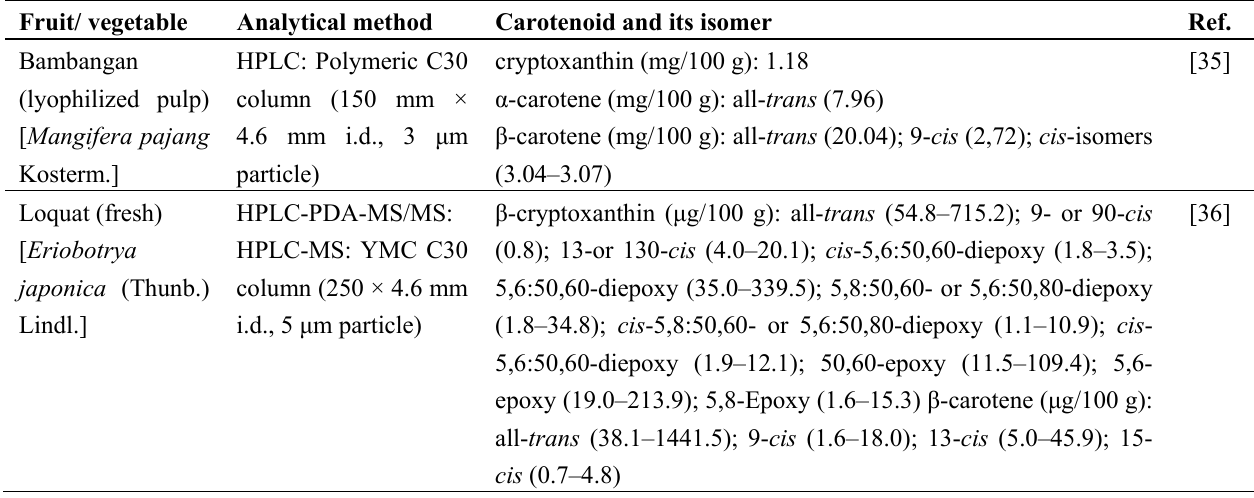
Table 1. Analyses of carotenoid isomers in fruits and vegetables. Fruit/